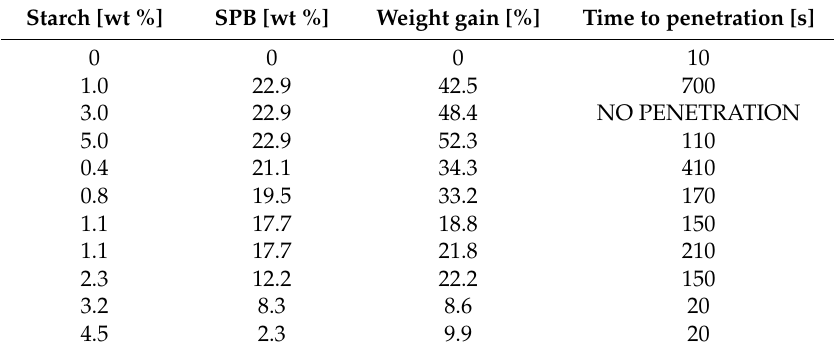
Table 3. Coating composition and resistance to a 100 mm flame penetration applied for 12 min on non-woven PET fabrics treated by starch/SPB coatings [37].